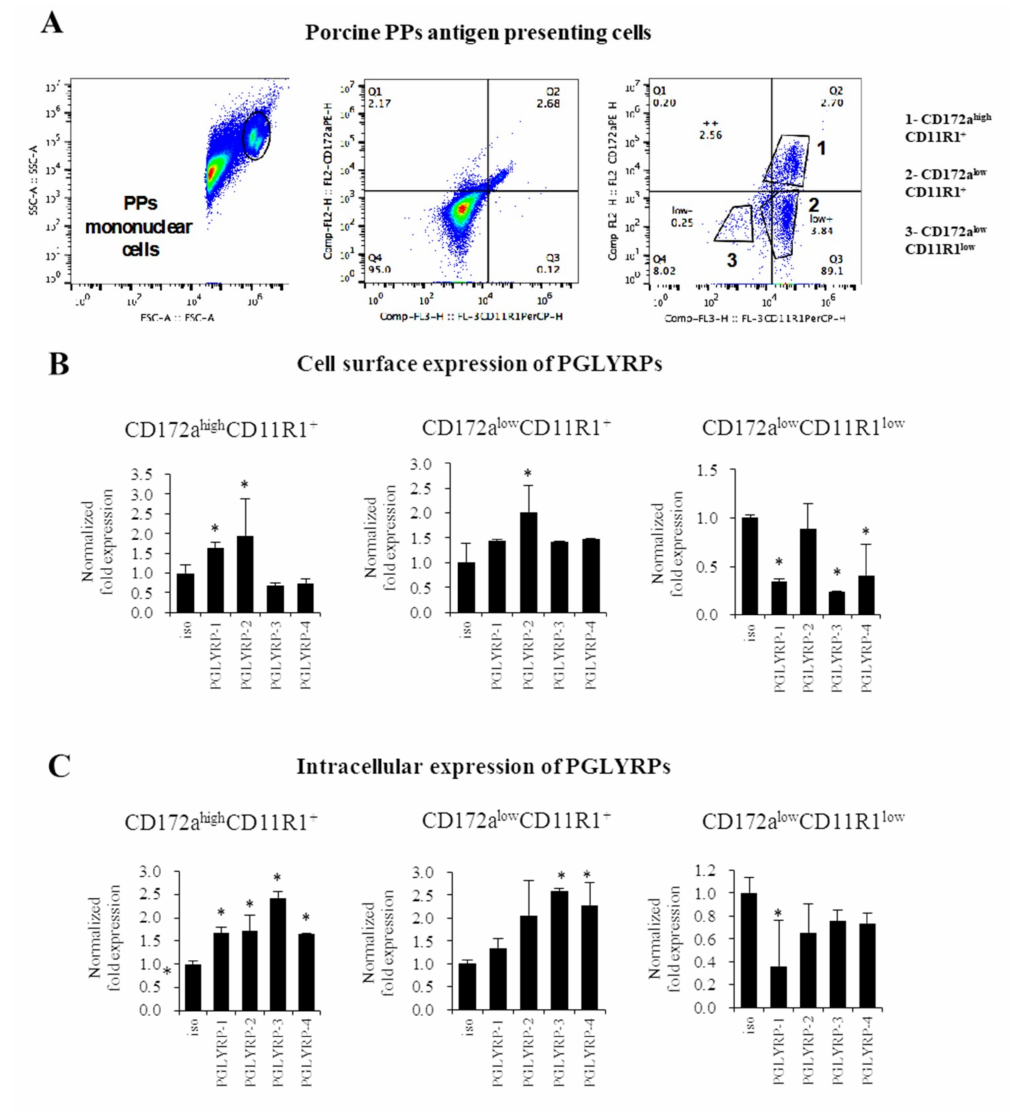
Figure 2. Expression and cellular localization of Peptidoglycan Recognition Proteins (PGLYRPs) in antigen-presenting cells (APCs) from porcine Peyer’s patches (PPs). Flow cytometric analysis of APCs populations from porcine PPs ( A ). APCs were divided into three populations using CD172a and CD11R1 markers and PGLYRP-1, -2, -3, and -4 expressions were evaluated in the surface ( B ) and in the cytoplasm ( C ). The results are shown as means ± standard deviation obtained from three independent experiments ( n = 6). * p < 0.05 against isotype control